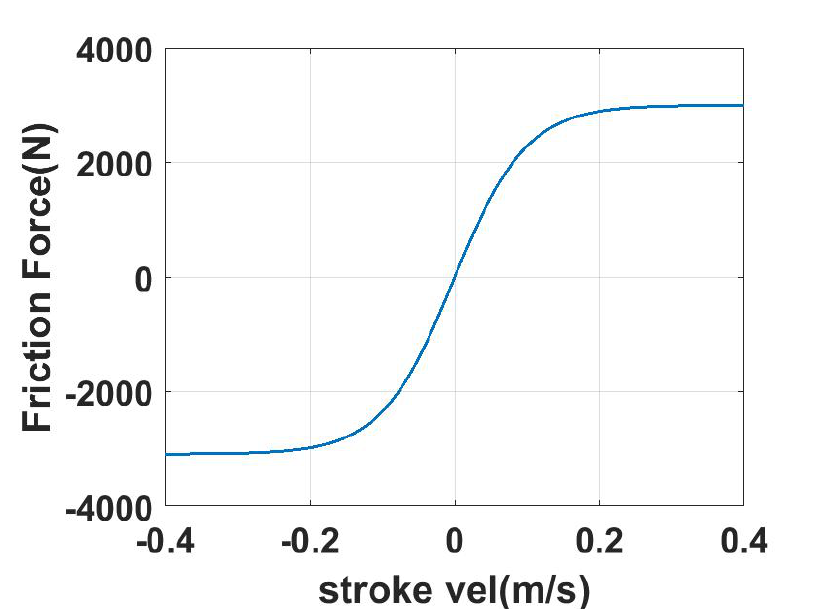
Figure 11. The friction force of the cylinder with different velocities when the cylinder force is 100